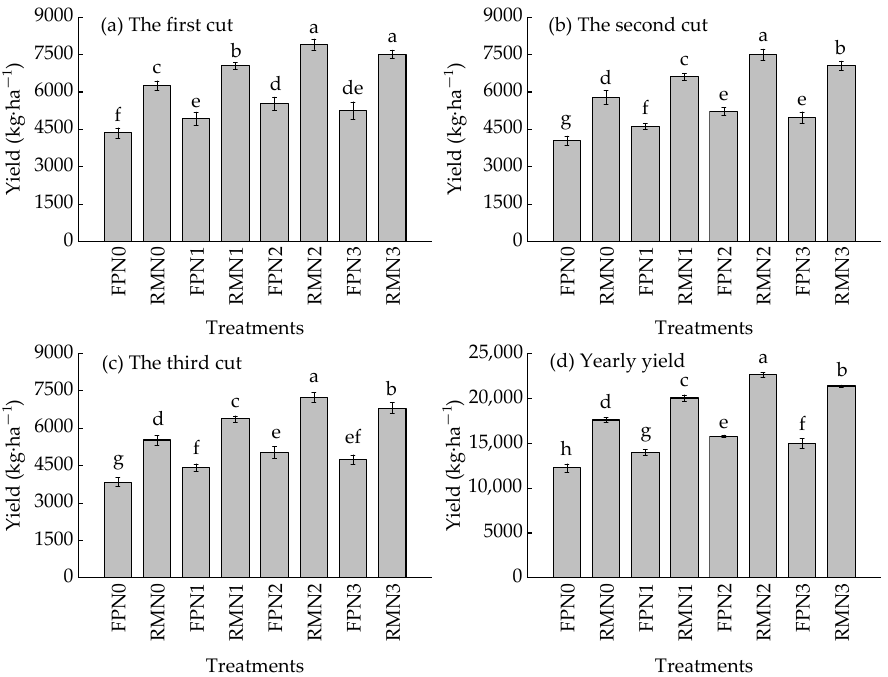
Figure 6. Impact of planting pattern and nitrogen level on alfalfa yield. FP and RM refer to con- ventional flat planting and ridge culture with film mulching, respectively. N0, N1, N2, and N3 refer to nitrogen application rates of 0 kg·ha − 1 , 80 kg·ha − 1 , 160 kg·ha − 1 , and 240 kg·ha − 1 . Different lowercase letters indicate significant difference among treatments ( p < 0.05).